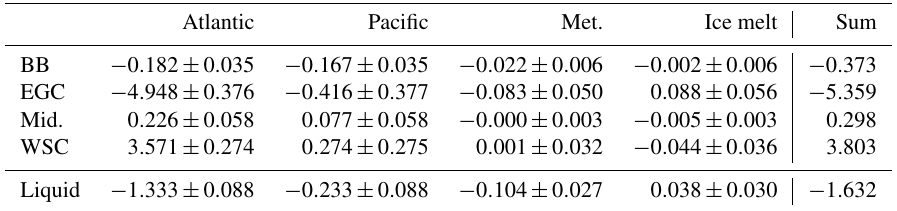
Figure 9. Sections of ice-modified fraction (a) , meteoric fraction (b) , Pacific fraction (c) and Atlantic fraction (d) , for the 4EM+ model, clockwise around the four gateways from Davis Strait to Bering Strait. Solid black lines indicate the isopycnal surfaces separating the main Arctic water masses as described in Tsubouchi et al. (2012). End members used were the mean of the literature values (see Tables 2 and 3). Note different colour scales for each panel. Table 7. Mean volume fluxes (Sv ± standard deviation) for the components of the Fram Strait flux (Belgica Bank, BB; East Greenland Current, EGC; mid-strait, Mid.; West Spitsbergen Current, WSC) from the four-end-member (4EM) model. Positive values indicate fluxes into the Arctic. Atlantic Pacific Met. Ice melt